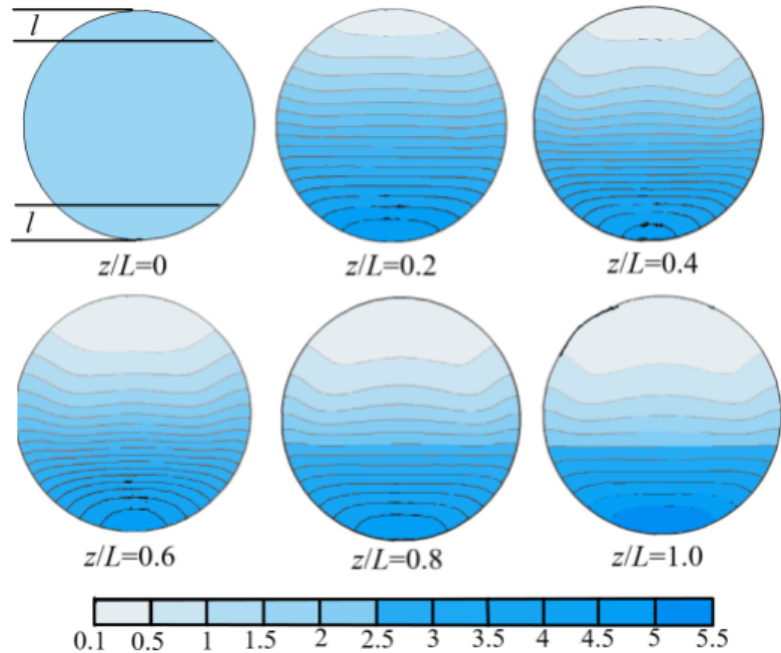
Figure 6. Particle volume distributions on different cross-sections along the flow direction ( d p = 100 µ m, V = 7 m/s, α s = 5%, m s = 15